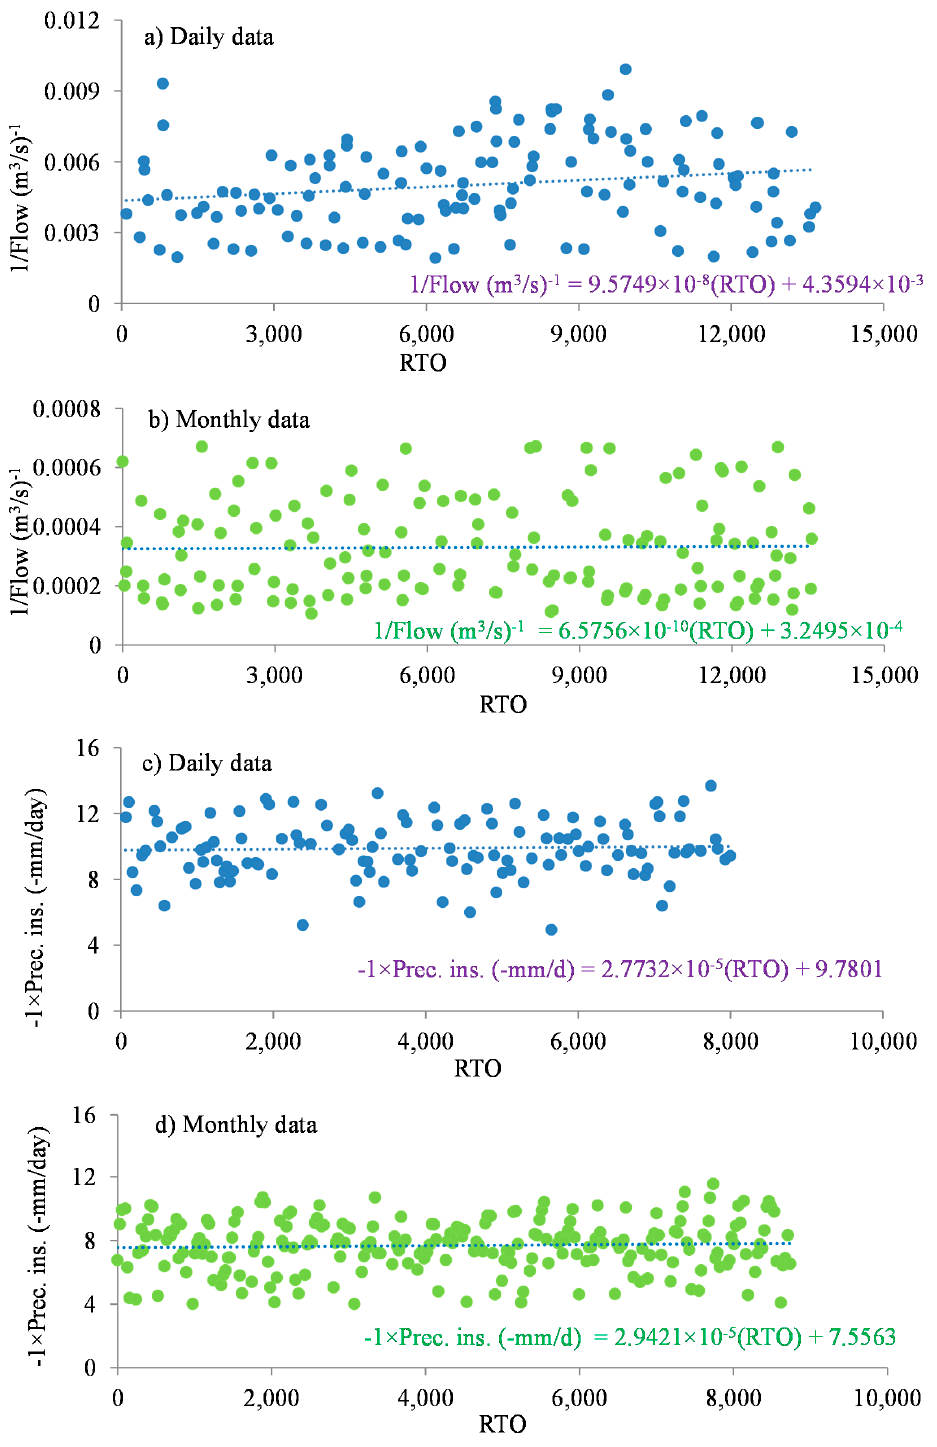
Figure 6. POT events of (1/ H ) low flow from 1965 to 2002 at Khartoum based on: ( a ) daily; and ( b ) monthly data; as well as the POTs from basin-wide ( − H ) precipitation insufficiency for the period 1979–2000 based on: ( c ) daily; and ( d ) monthly data. The dotted line is a linear trend.